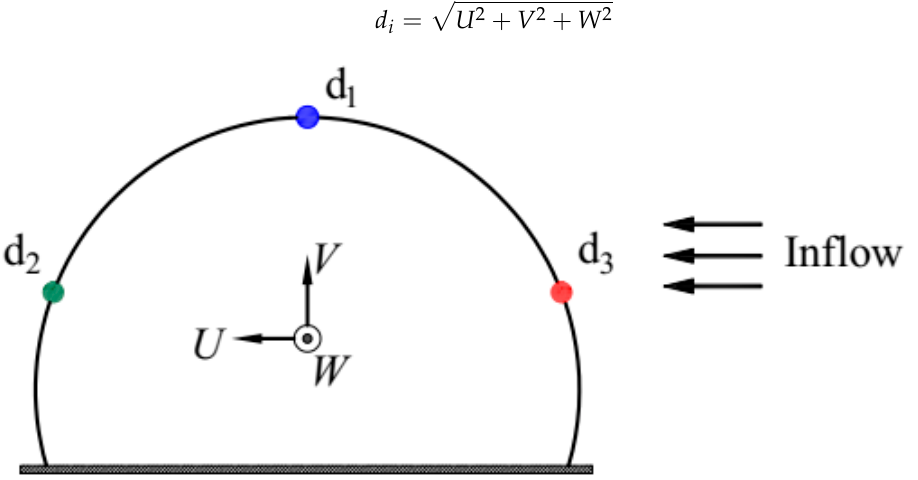
Figure 5. Diagram of characteristic measurement points for the stereo cameras.